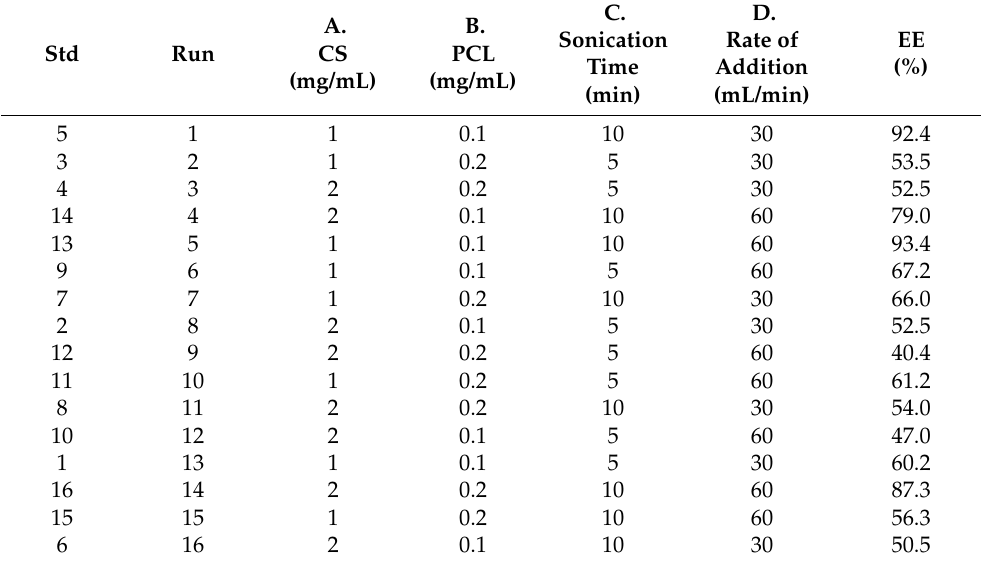
Table 1. Compiled data of all the statistical runs performed for all the formulated batches of APO-NPs under 2 4 factorial